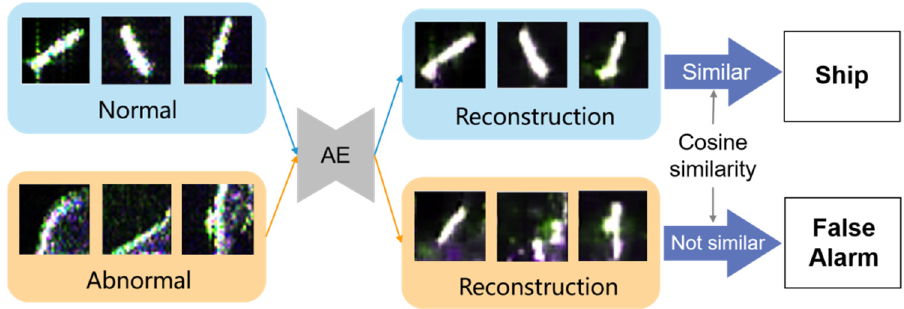
Figure 16. Schematic diagram of an autoencoder for anomaly